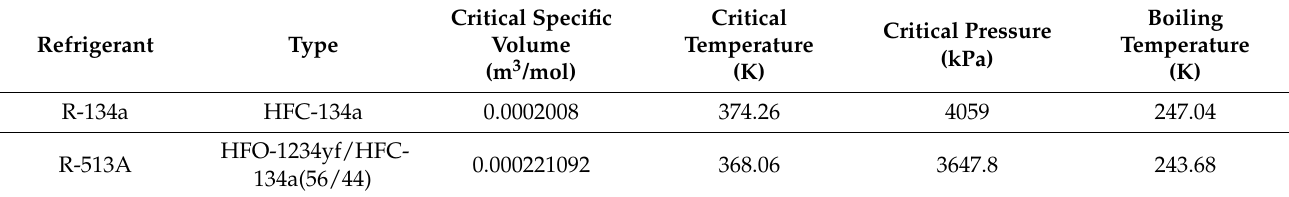
Table 2. Properties of R-134a refrigerant and R-513A refrigerant Table 1. Physical properties of R-134a refrigerant and R-513A refrigerant [22].